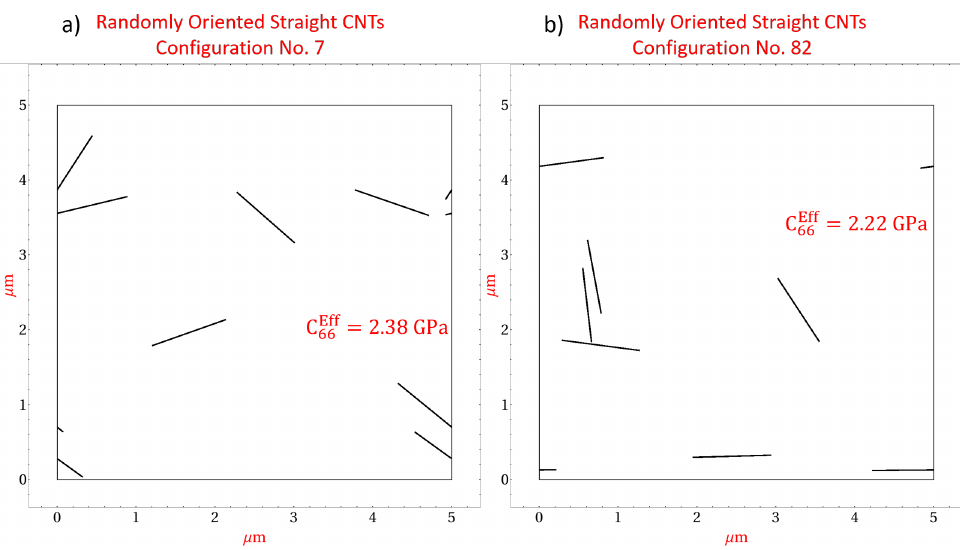
Figure 9. Microscale realizations with straight randomly oriented CNTs at 0.56% CNT volume fraction depicting the effect of CNT orientation on stiffness component C 66 .